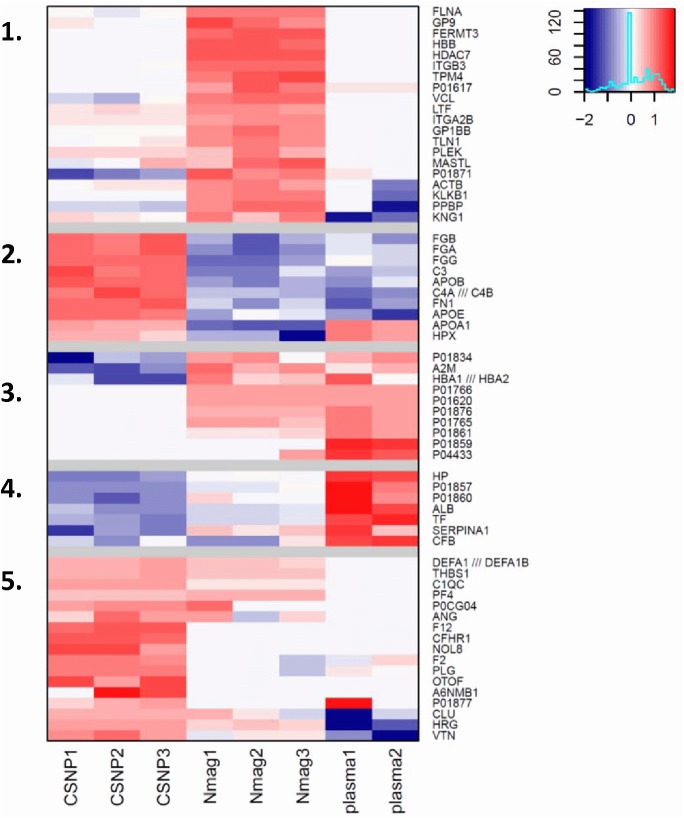
Distinct plasma protein corona composition on SPIONs with different surface coating.Cluster analysis of SPION-bound plasma proteins versus plasma proteins. Red color denotes counts higher than average when compared to other samples. Blue denotes counts lower than average (refer to legend top right corner). Clusters are numbered 1–5 (cf. S4 Table). Clusters 2 and 5 contain proteins that are enriched in the CSNP corona. Cluster 1 proteins are enriched in the nanomag-D-spio corona and clusters 3–4 contain plasma-enriched proteins. For gene ontology (GO) enrichment analysis of the corona-specific clusters, refer to Figs 5 and S5.